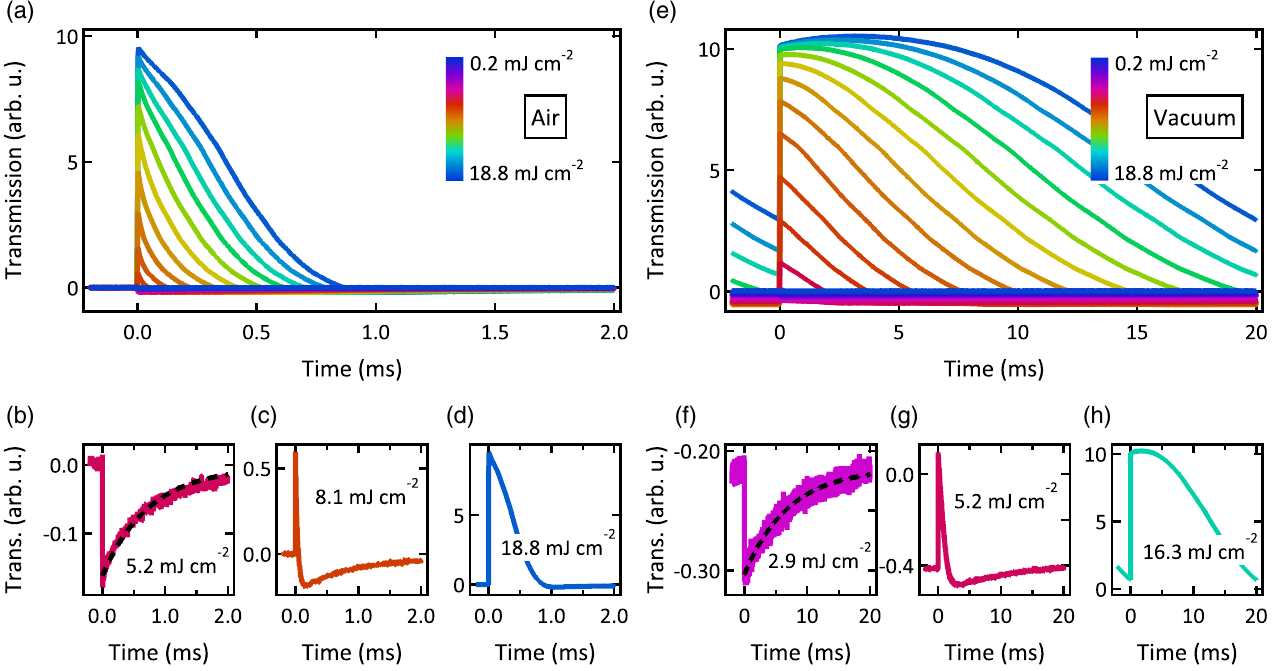
FIG. 1. Cooling dynamics of freestanding VO 2 films. (a) Optical response at 50 Hz, room temperature, and atmospheric pressure. Three fluence regimes can be distinguished: below (b) and above (c) the phase-transition threshold, and the saturation regime (d), where the optical properties no longer change with increasing fluence. Much slower relaxation dynamics can be observed when the sample is held in vacuum (e), which leads to lower values for the thresholds of the fluence regimes. Below the phase-transition threshold (f), the system shows a longer recovery time, and 5 . 2 mJ cm 2 is sufficient to induce the phase transition (g). The offset present at negative time delays is positive (h) if the sample remains partially metallic when the next pump pulse